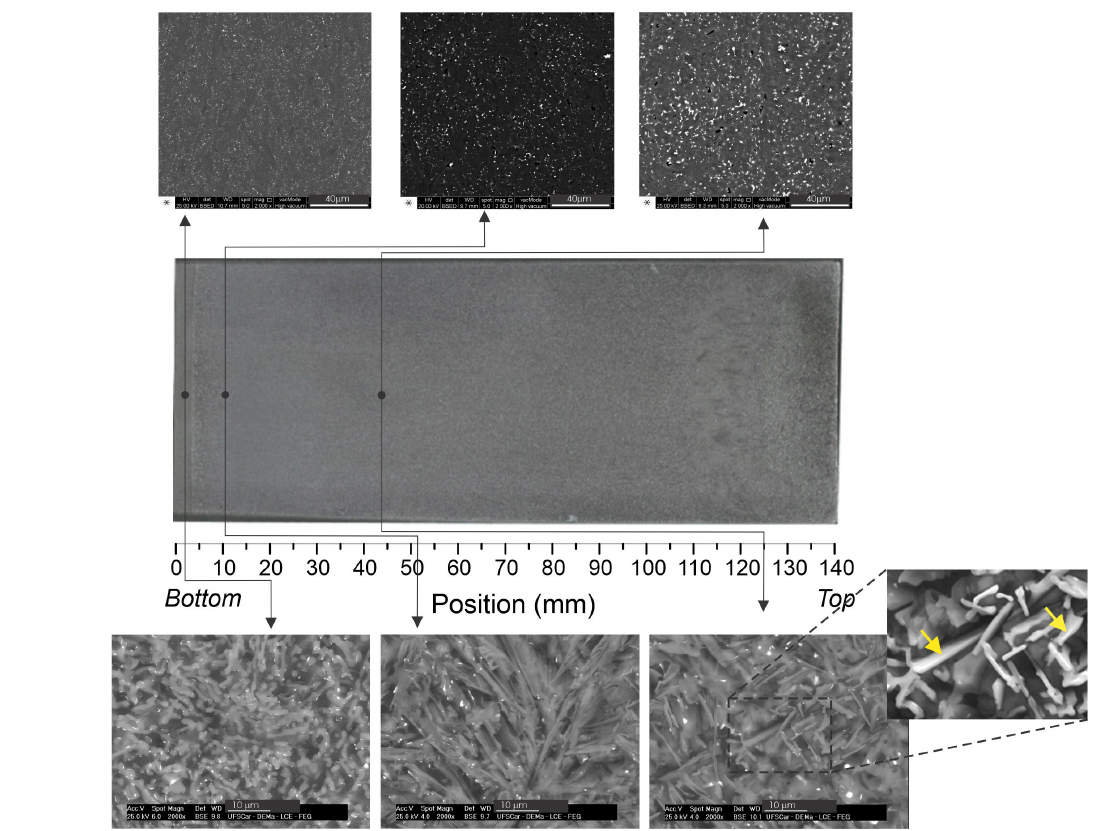
Figure 2. SEM images showing details of the microstructure found in the Al-15 wt.%Si-1.0 wt.%Bi alloy. The upper row shows the Bi droplets while the lower set of images highlights the Si particles.